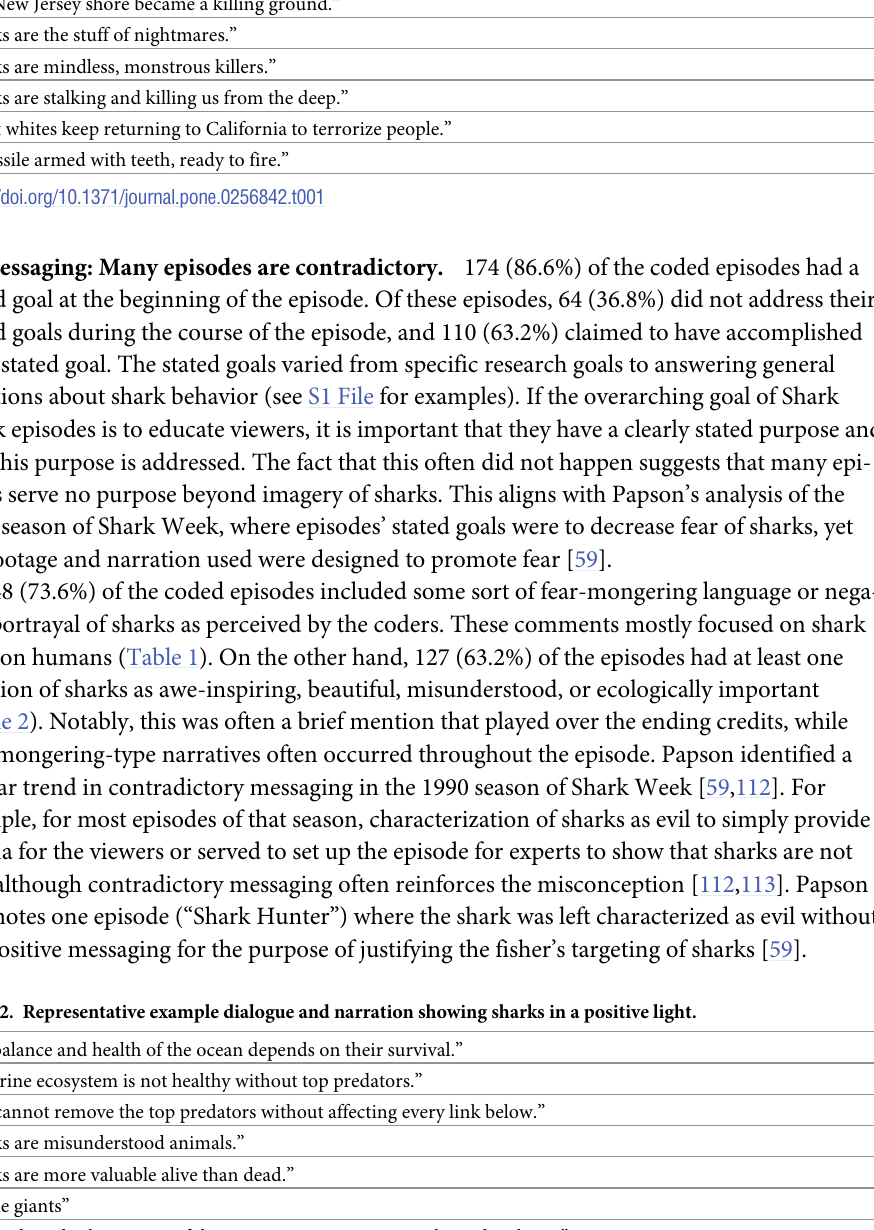
Table 1. Representative example dialogue and narration showing sharks in a negative light. “Biologists know little of what makes these killing machines tick.” “The threat against humans from sharks has never been greater.” “Deadly maneaters lurking in the shadows.” “You can’t outswim a shark, and you can’t overpower it.” “Great white sharks can be absolute monsters.” “The New Jersey shore became a killing ground.” “Sharks are the stuff of nightmares.” “Sharks are mindless, monstrous killers.” “Sharks are stalking and killing us from the deep.” “Great whites keep returning to California to terrorize